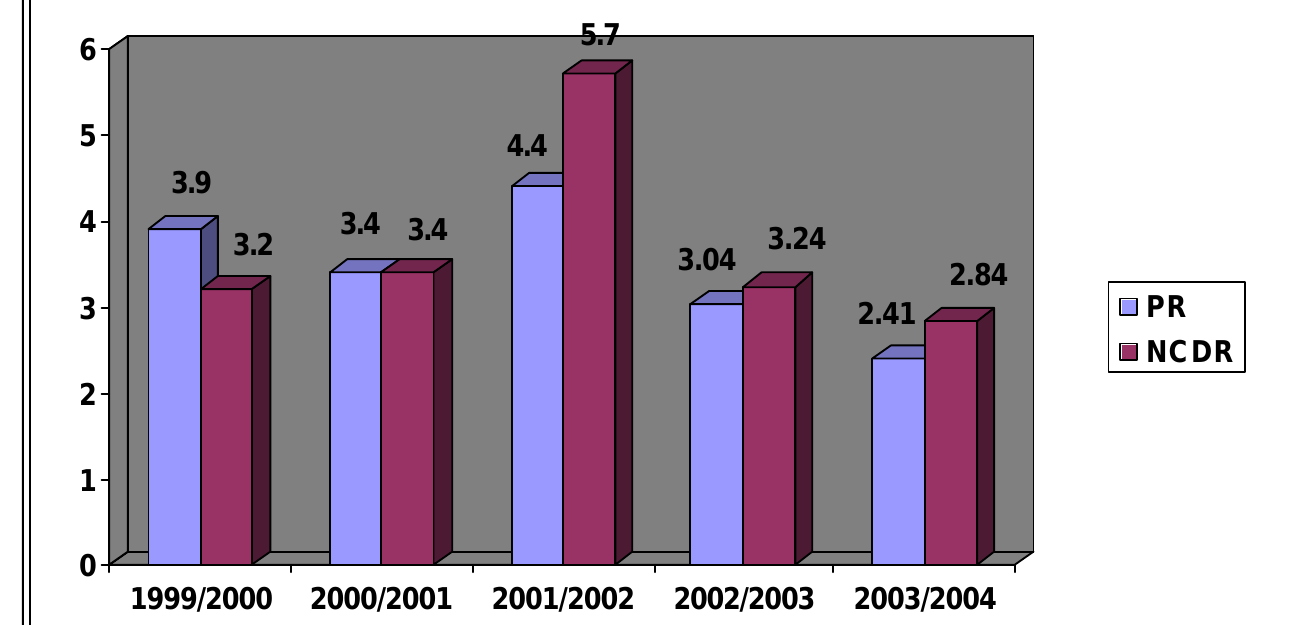
Fig. 1 : Prevalence Rate (PR) & New Care Detection Rate (NCDR) Trend of